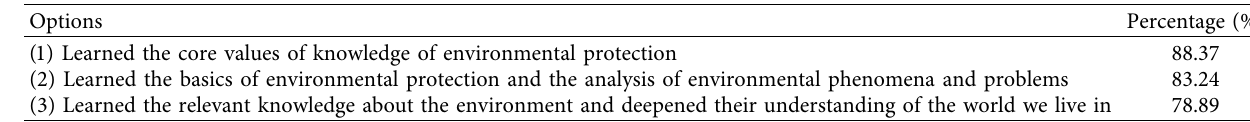
Table 5: College students’ sense of knowledge acquisition.